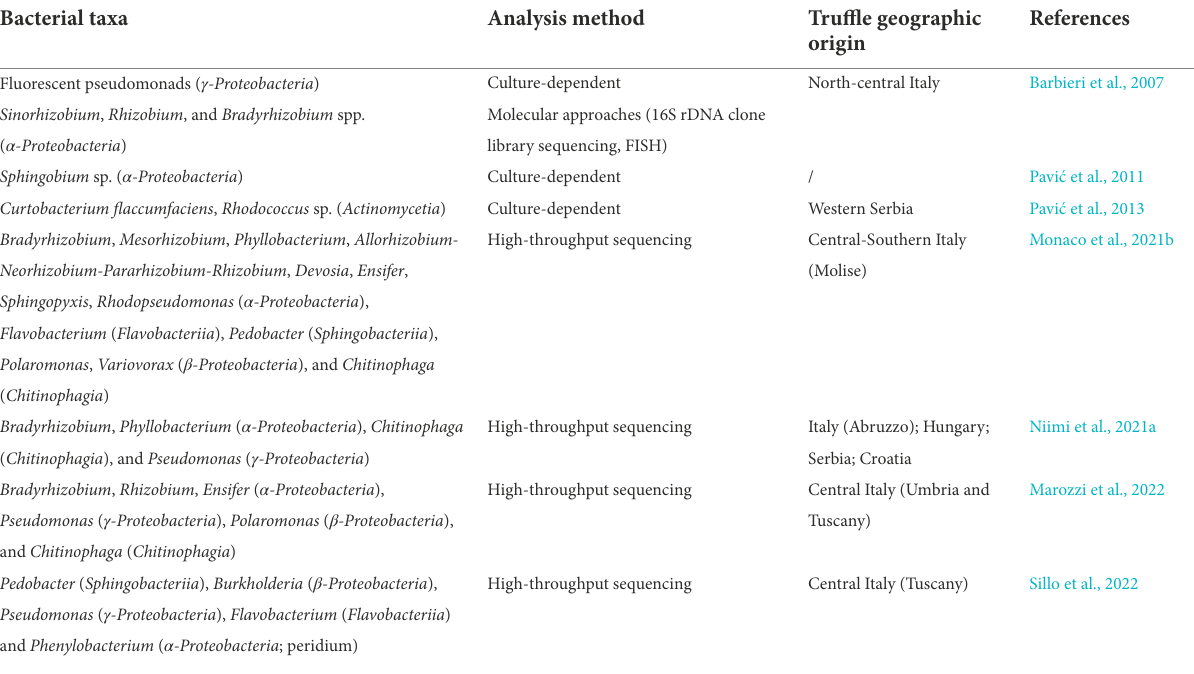
TABLE 1 Main bacterial taxa associated with Tuber magnatum ascocarps reported in